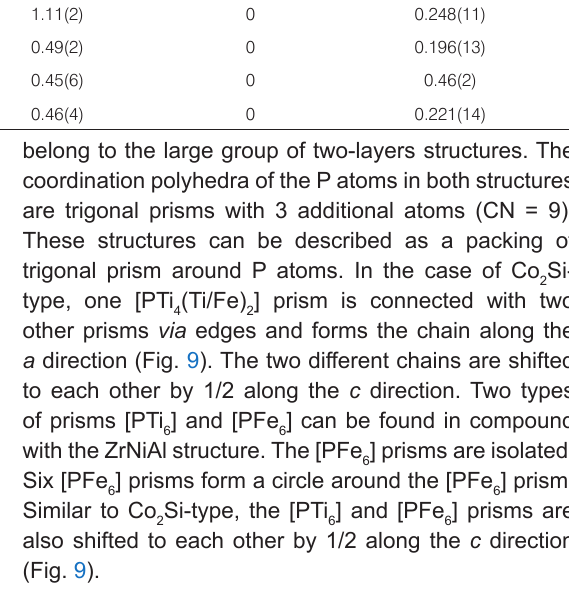
Fe P (Co Si-type); tick 0.5-0.8 1.5-1.2 2